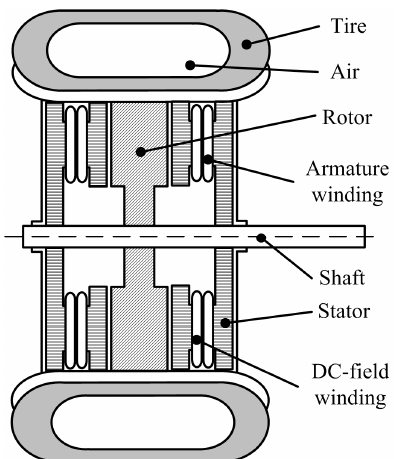
Figure 3. In-wheel direct drive internal